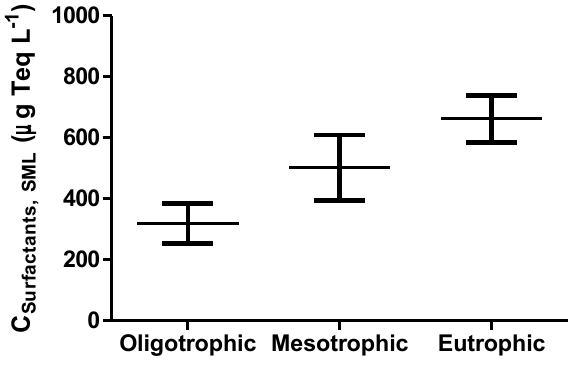
Fig. 7. Mean concentrations of surfactants in the SML at the three trophic states. The bars represent the 95% confidence intervals of the